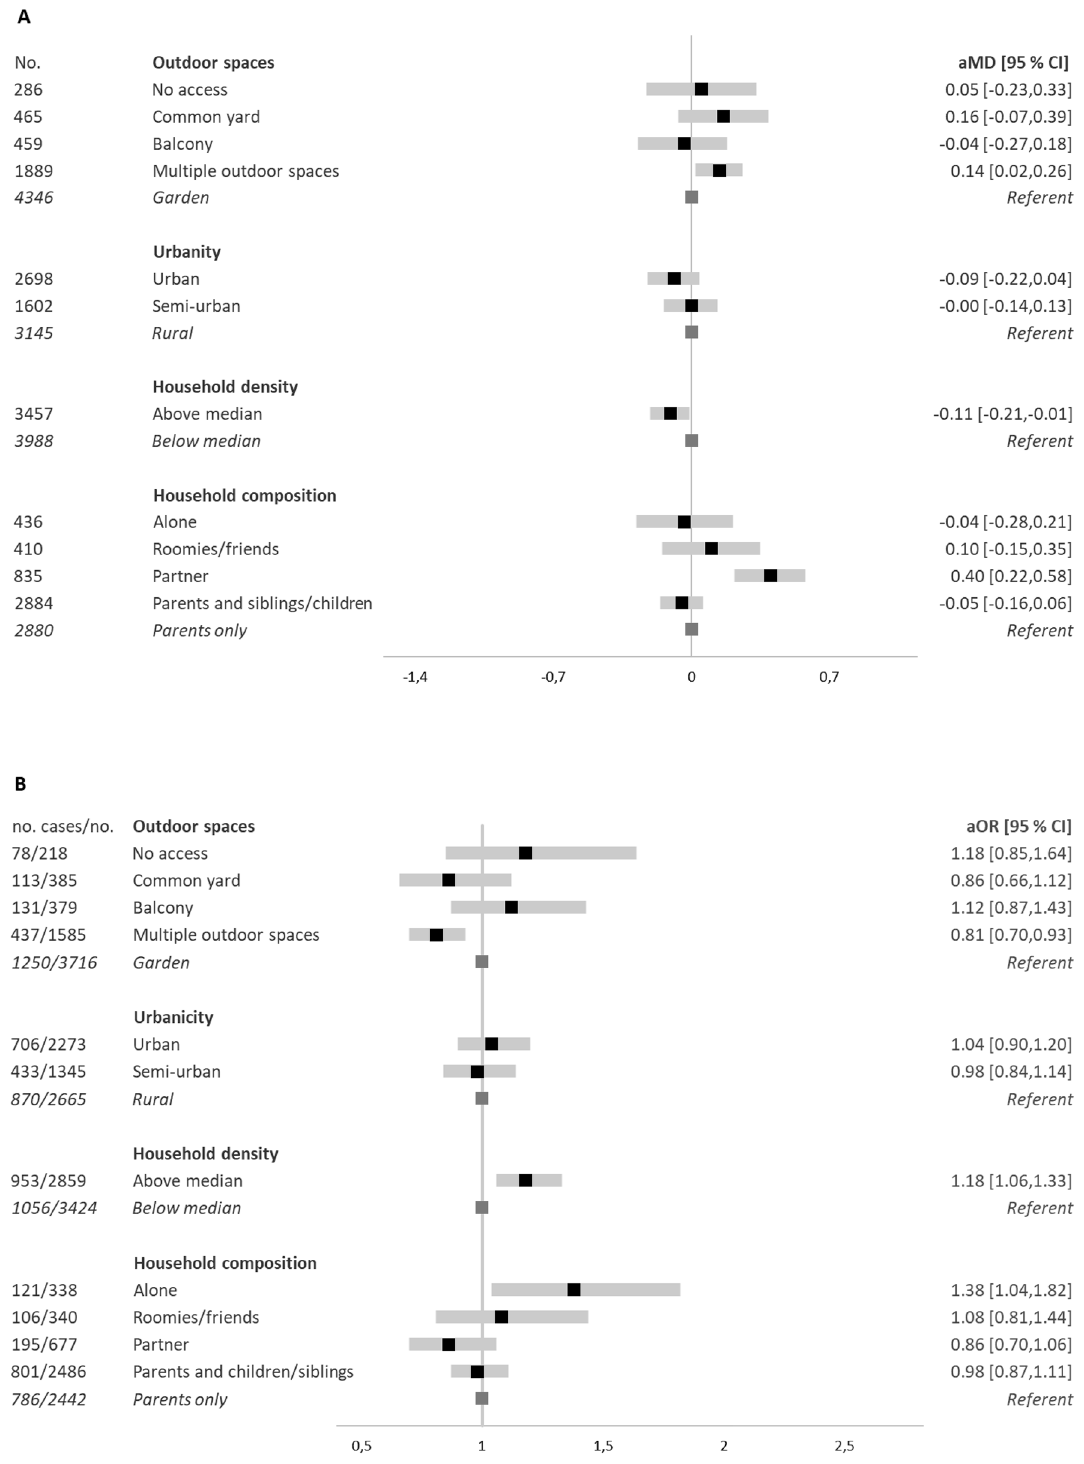
Figure 5. Changes in QoL ( A ) and onset of low QoL ( B ) according to housing conditions. QoL Quality of Life, aMD Adjusted Mean Difference, aOR Adjusted Odds Ratios, CI Confidence Intervals. aMD and 95% CI and aOR and 95% CI are presented. Population at-risk of developing low QoL(No. = 6283). Adjusted model 2: adjusted for age, sex, current education, part-time work, moving, geographical region, and mutually adjusted for housing